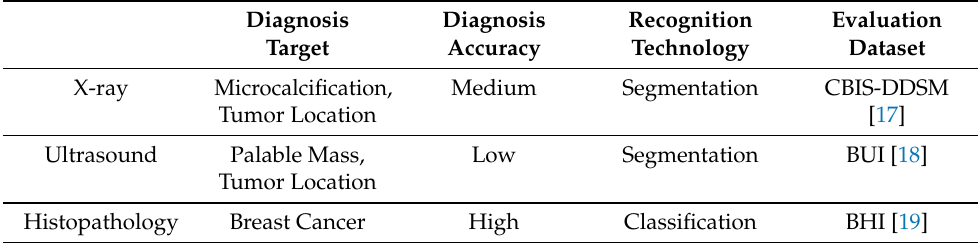
Table 1. Image Recognition Technique and dataset for each medical images. Diagnosis Diagnosis Recognition Evaluation Target Accuracy Technology